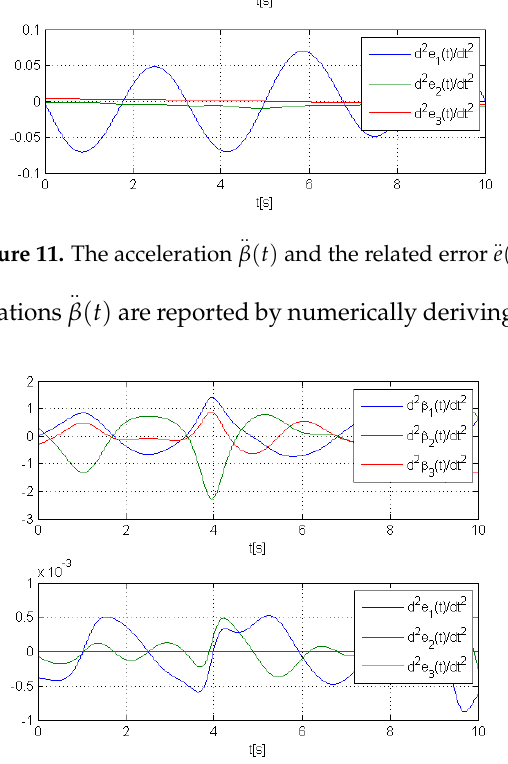
. β ( t ) , and the related error  and the related error  and the related error  and the related error